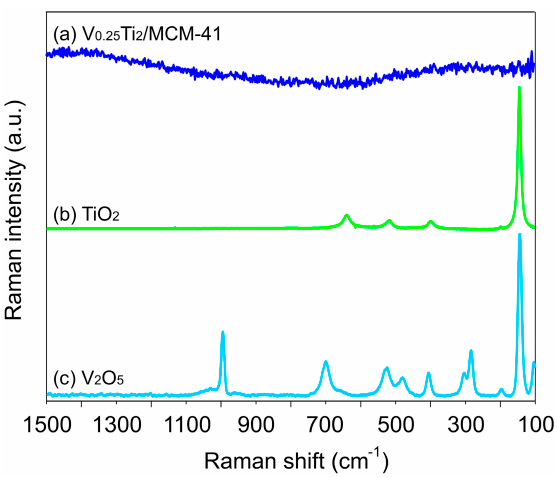
Figure 2. The 514 nm Raman spectra of ( a ) V 0.25 Ti 2 /MCM-41, ( b ) TiO 2 anatase and ( c ) V 2 O 5 catalysts under ambient